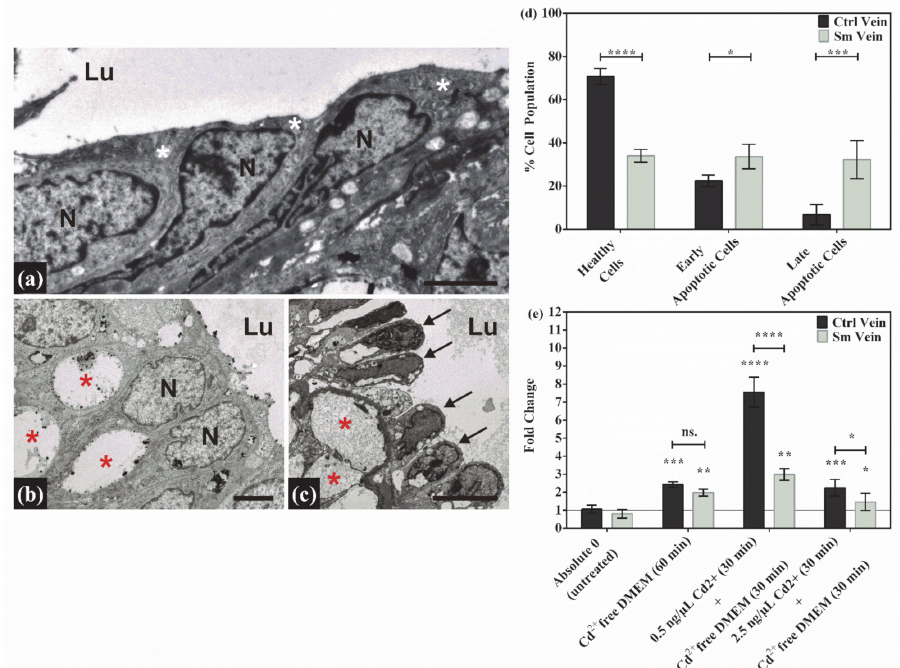
Figure 1. Morphological changes, viability and reactivity in Ctrl and Sm umbilical cord (UC) vessels. On the representative electron micrographs focusing on the endothelial layer, significant changes can be observed compared to the Ctrl ( a ) endothelial cells (white asterisks) with the Sm artery ( b ) and Sm vein ( c ) endothelial cells (black arrows). In addition to losing their intercellular contacts, cells also show damaged/dying phenotypic features in the cytoplasm and nuclei ( N ). The most remarkable is the nuclear fragmentation and the occupancy of intra- and intercellular vacuoles (red asterisks) at the expense of the cytoplasm. Scale bars: 2 µ m ( a ); 2 µ m ( b ); 5 µ m ( c ). (Lu = vessel lumen). ( d ) Graphical presentation of the viability assay data set on isolated Ctrl- and Sm-derived human umbilical vein endothelial cell (HUVEC) populations. Flow-cytometer-quantified data are ordered on the interleaved bar graph, where the percentage distribution of healthy, early and late apoptotic cells are expressed within the whole isolated Ctrl and Sm populations, and shown as mean ±